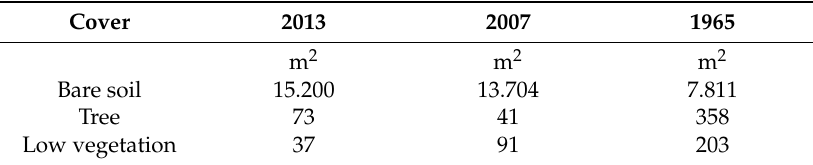
Table 9. Mean patch area (AREA_MN) for the different